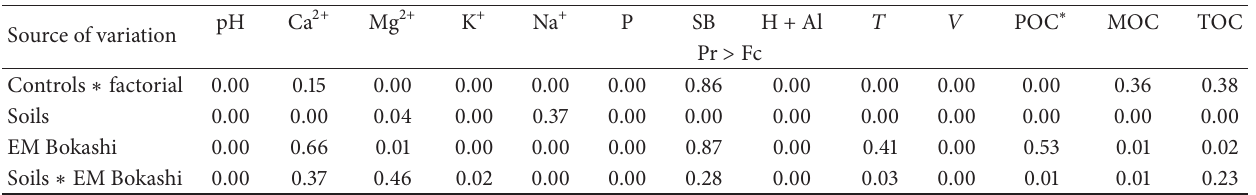
Table 2: 𝑃 values of the evaluated soil fertility attributes and of the physical fractions of the soil organic matter and for the contents of TOC data. pH Ca 2+ Mg 2+ K + Na + P SB H + Al 𝑇 𝑉 POC ∗ MOC TOC Source of variation Pr > Fc Controls ∗ factorial 0.00 0.15 0.00 0.00 0.00 0.00 Soils 0.00 0.00 0.04 0.00 0.37 0.00 0.00 0.00 EM Bokashi 0.00 Soils ∗ EM